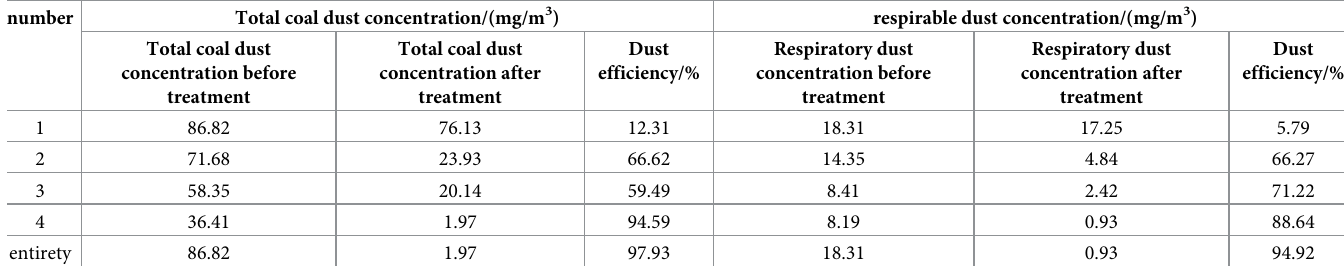
Table 6. Comparison of coal dust concentration before and after treatment in the return airway of the 00 working face. number Total coal dust concentration/(mg/m 3